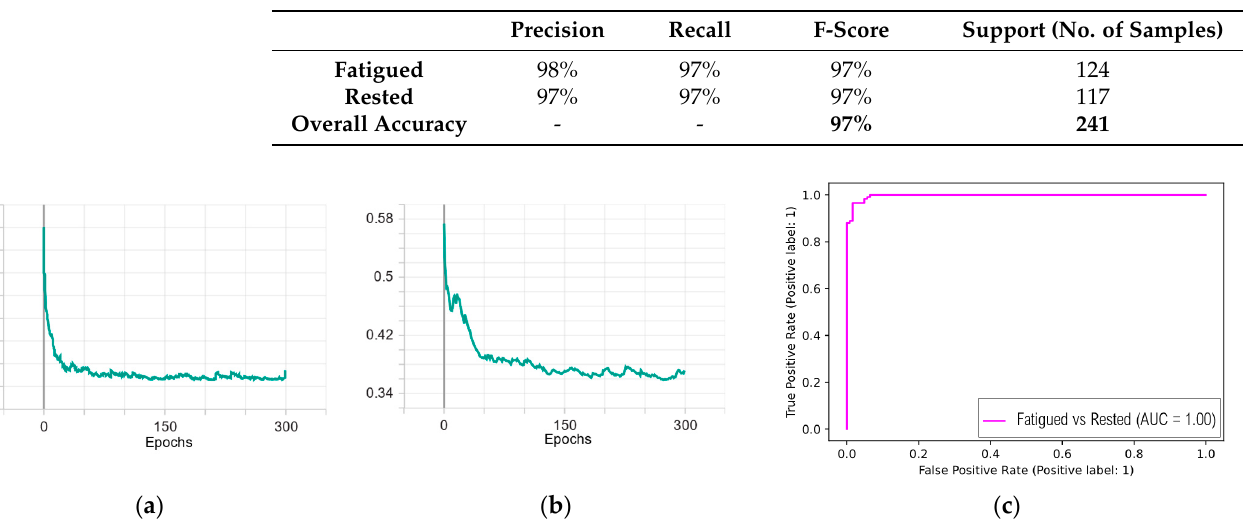
Figure 2. The proposed model performance regarding: ( a ) train loss over the epochs; ( b ) validation loss over the epochs; ( c ) receiver operating characteristic (ROC) curve.